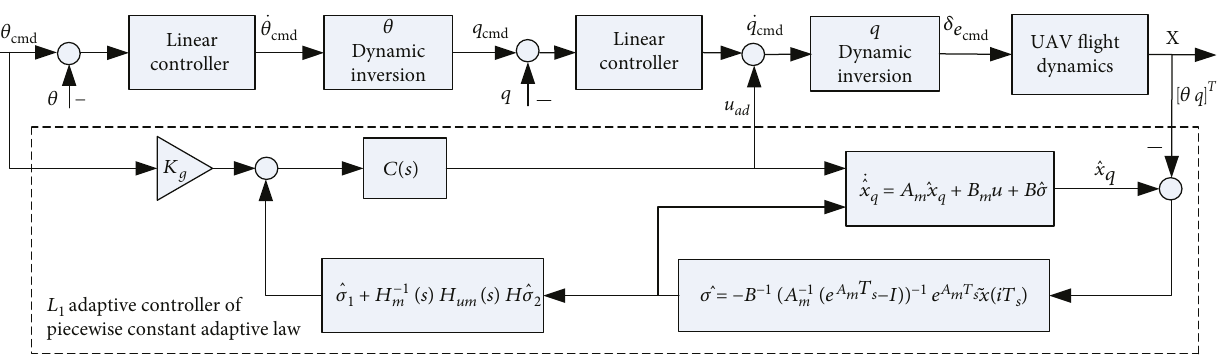
Figure 2: Block diagram of L adaptive controller of piecewise constant adaptive law for pitch 1